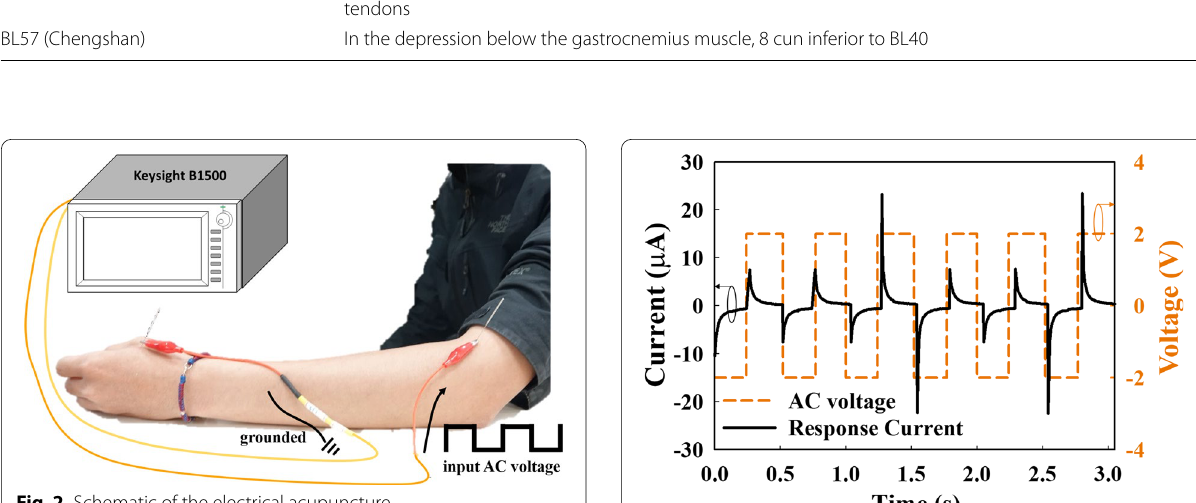
Fig. 2 Schematic of the electrical acupuncture